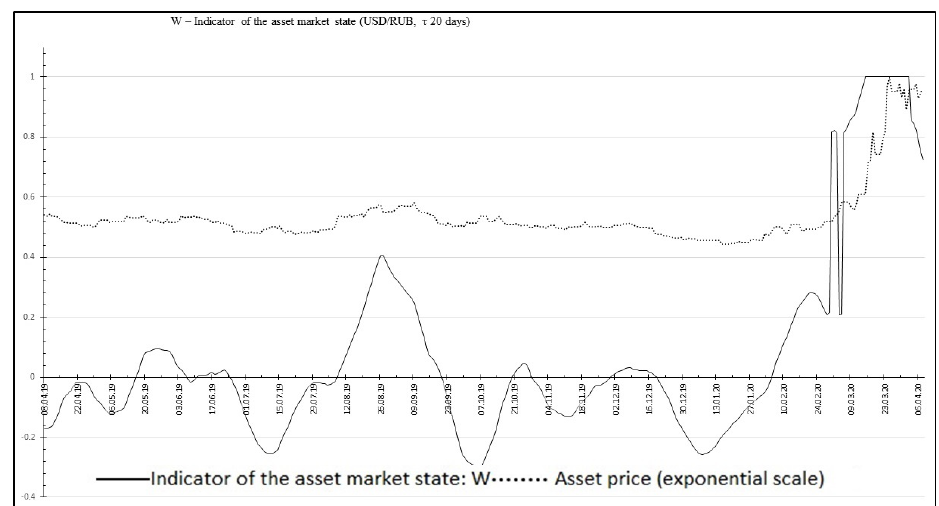
Figure 3. Graph of applying the function W i